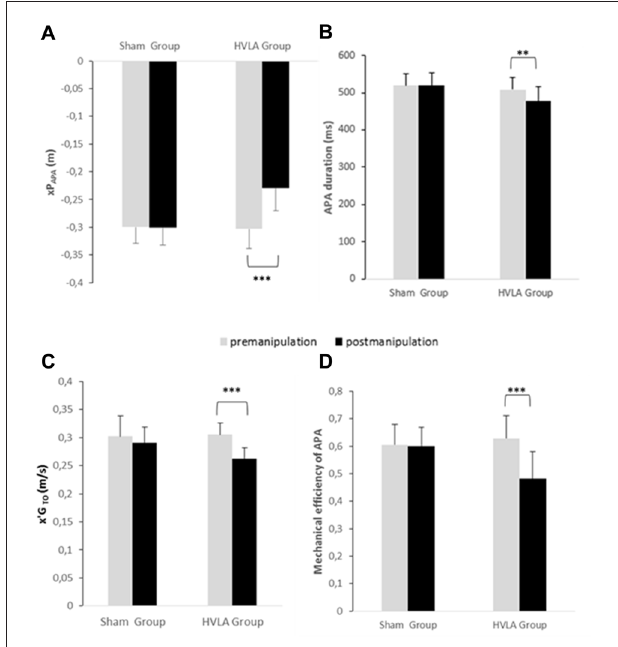
FIGURE 5 | Comparison of APAs related variables between the pre- and post-manipulation conditions in the sham and HVLA groups. (A) xP APA : peak of anticipatory backward center of pressure displacement, (B) APA duration, (C) x (cid:48) G TOT : center of gravity velocity at TO and (D) mechanical efficiency of APAs. ∗∗ , ∗∗∗ Statistical difference with p < 0.01, p < 0.001, respectively. Values given are means ± 1 standard error.